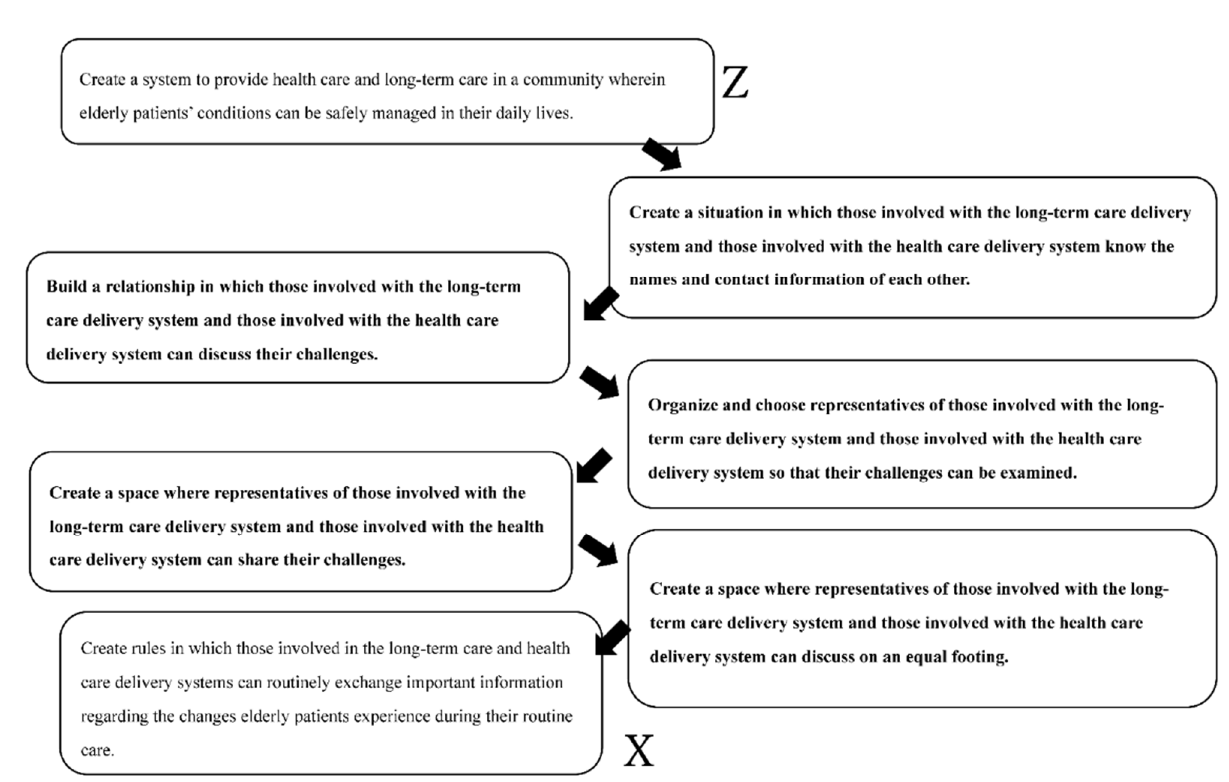
Figure 2. Conceptual model.